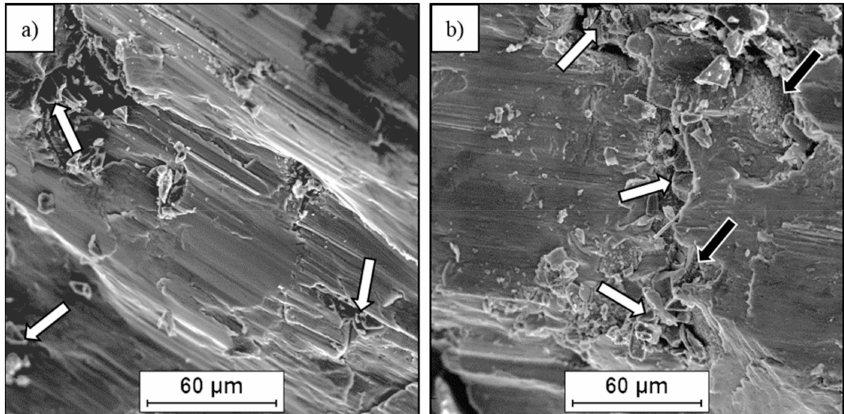
Figure 9. SEM micrographs of fractured surface after compression tests: ( a ) C of –Mg, ( b ) C of –AZ31 composites, shear bands in magnesium matrix, scraps of destroyed carbon foam (white arrows), agglomerates of fine phases (black